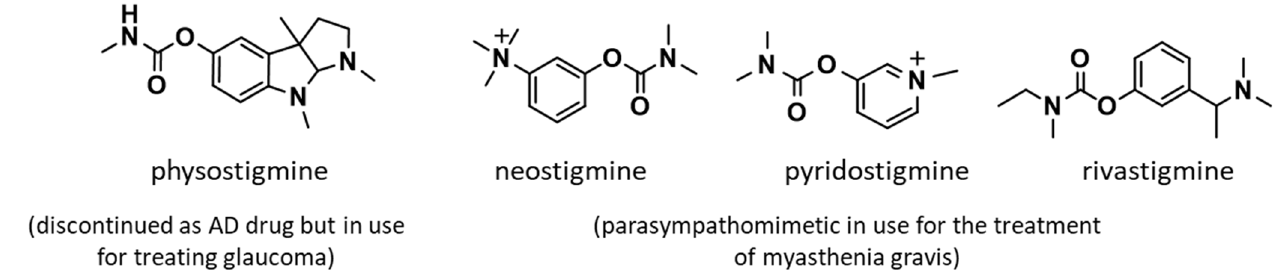
Figure 1. Carbamate based drugs that are or have been used for treatment of AD.